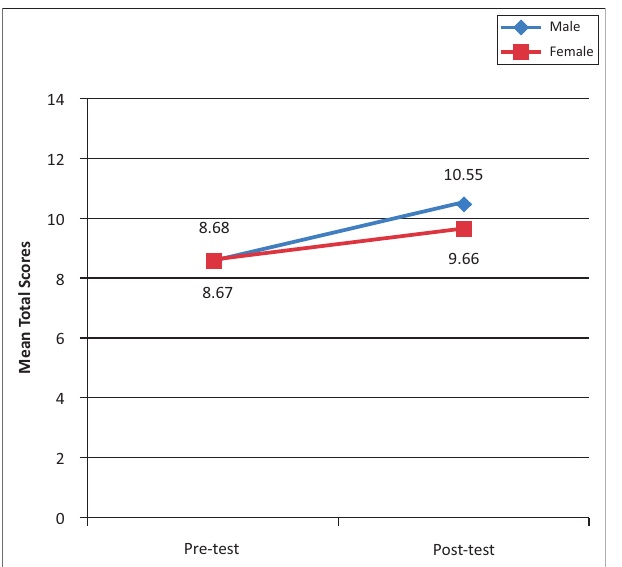
FIGURE 3: Pre-test and post-test scores for male and female participants.